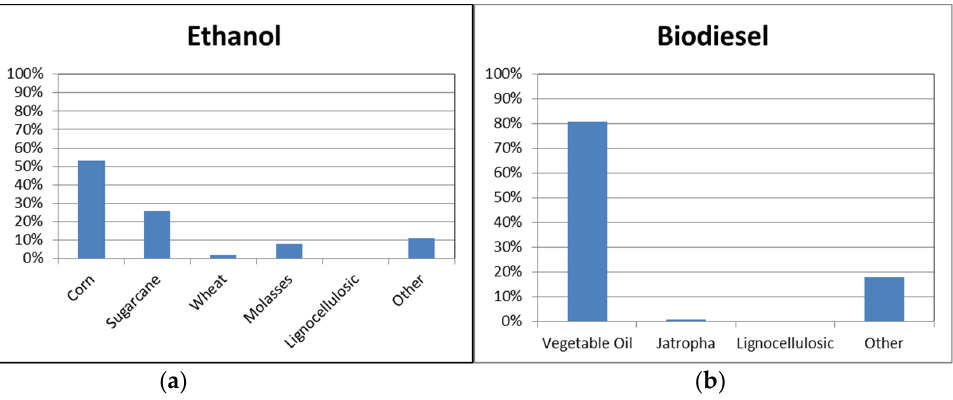
Figure 3. Shares of global ethanol ( a ) and biodiesel ( b ) production by feedstock type for 2013–2015. The y ‐axis represents the % share of each feedstock used (Source: Data adapted from [16]. Note: Sugar crops include ethanol produced from sugar cane as well as sugar beets in the European Union).